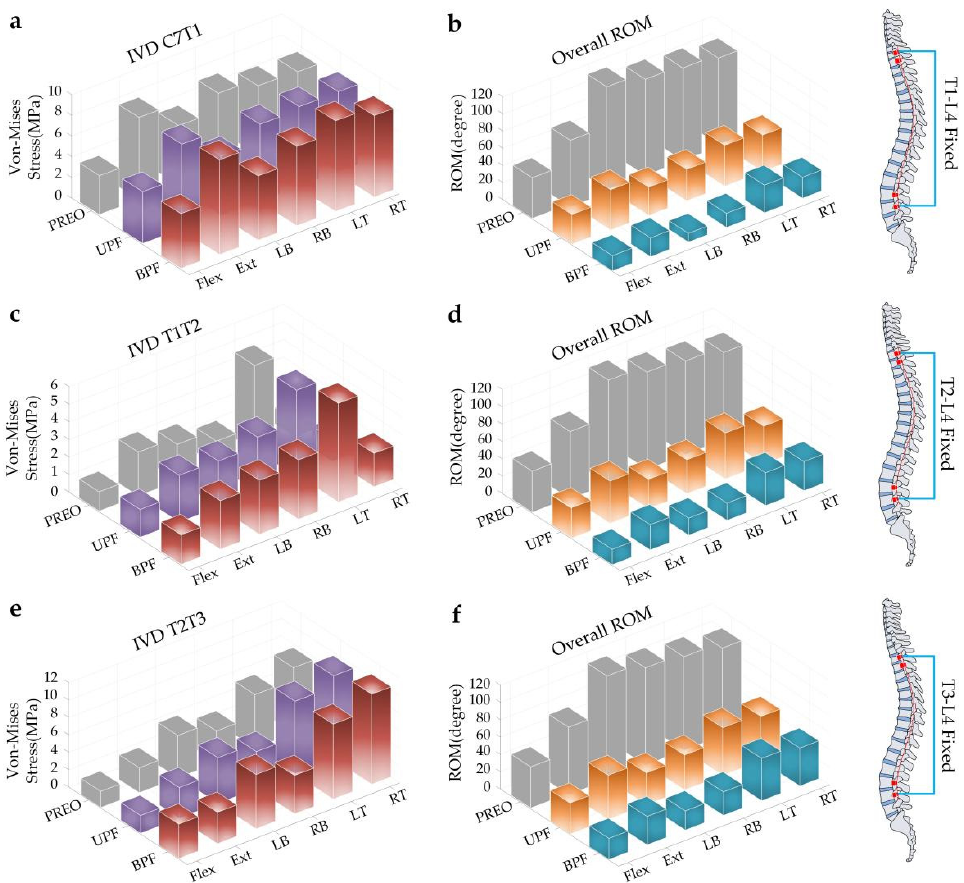
Figure 6. SAS IVD stress and overall ROM of different surgical procedures under torque